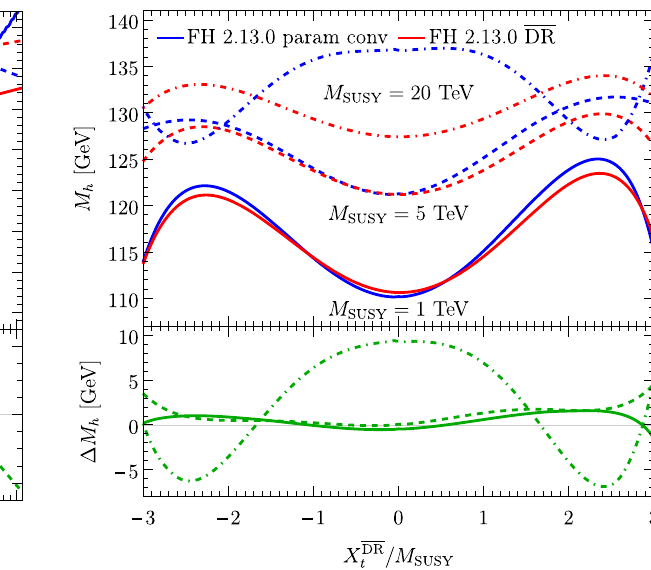
for M SUSY = 1 TeV (solid), M SUSY = 5 TeV (dashed) and M SUSY = 20 TeV (dot-dashed). In the bottom panels, the difference between the blue and red curves is shown ( Δ M h = M h ( FH 2.13.0 param conv ) − M h ( FH 2.13.0 DR )